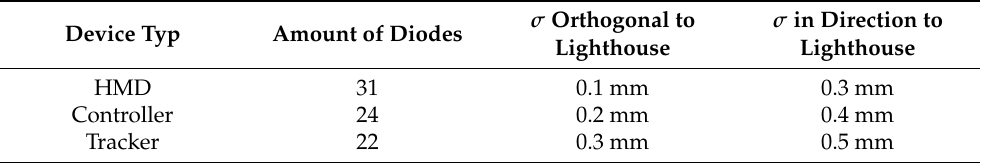
Table 2. Numerical values for the noise distribution of different devices.